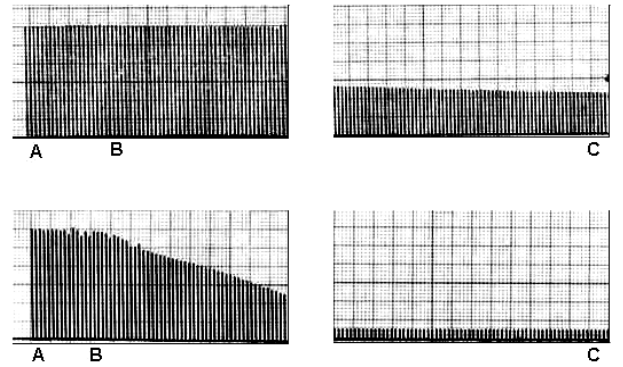
In experiments in vivo , accomplished in sciatic exter- nal popliteal nerve - tibialis anterior muscle preparation, the blockade produced by rocuronium (93.4 ± 4.21%) was signifi- cantly larger (p=0.0081) in rats exposed to phenobarbital, in relation to the observed in not exposed (66.7± 6,92%). The amplitude of muscular responses at 60 minutes after the addi- tion of rocuronium were 33.3% and 6.6% in the preparations not exposed and exposed to Phenobarbital. Respectively (Fig- ure 3).